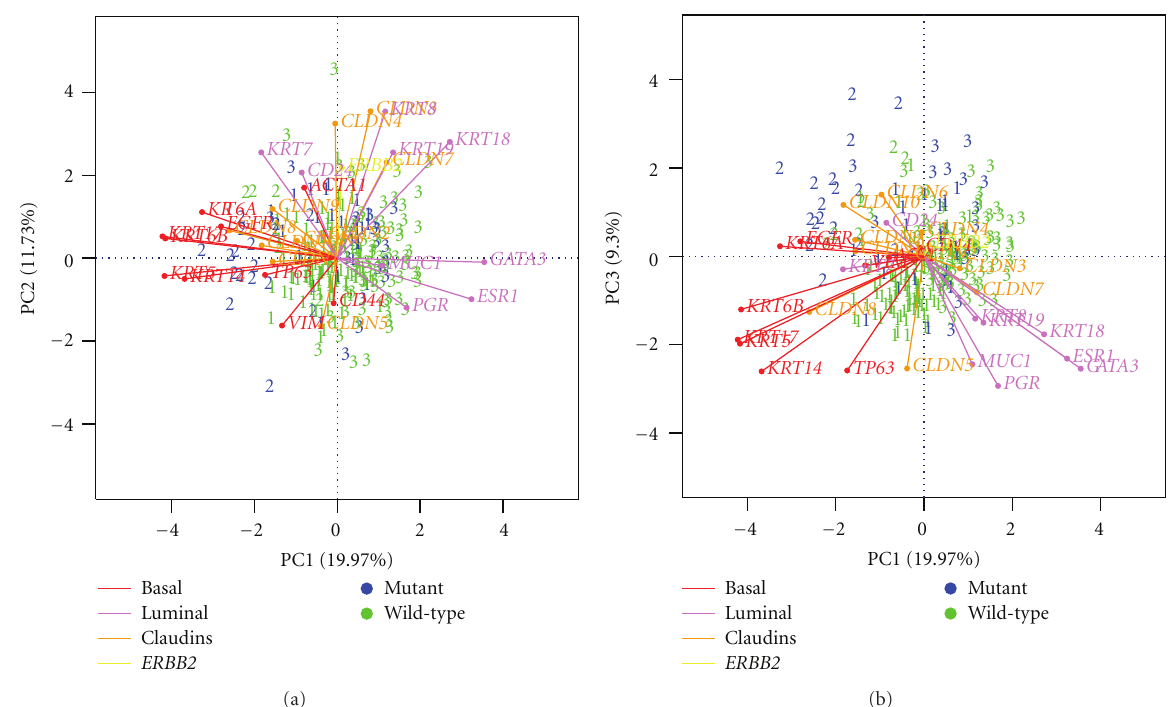
Figure 6: Active PCA-based biplots of intrinsic breast cancer phenotype-related genes. Samples are colored according to the mutational p53 status (wild-type in green and mutant in blue) and are labeled according to the corresponding cluster (1, 2, or 3). Loading for basal genes are represented by red arrows, luminal genes by pink arrows, claudin genes by orange arrows, and ERBB2 gene by yellow